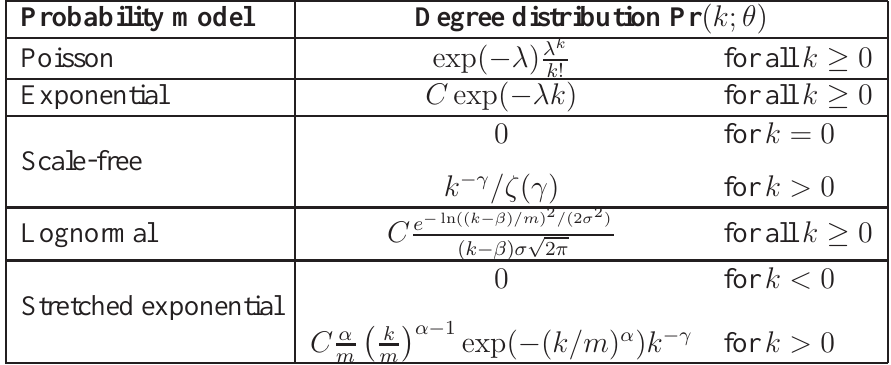
k ; θ ) = 1 . In k Pr ( P